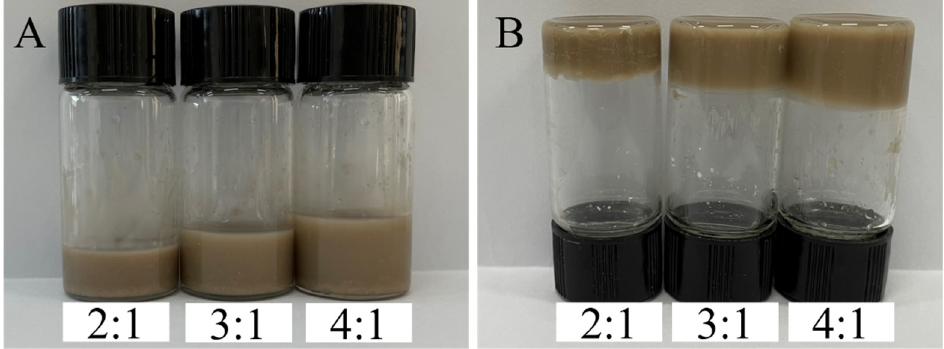
Figure 6. TCPP-CaMMT gel with different TCPP/CaMMT ratios. ( A ) before gel; ( B ) after gel.